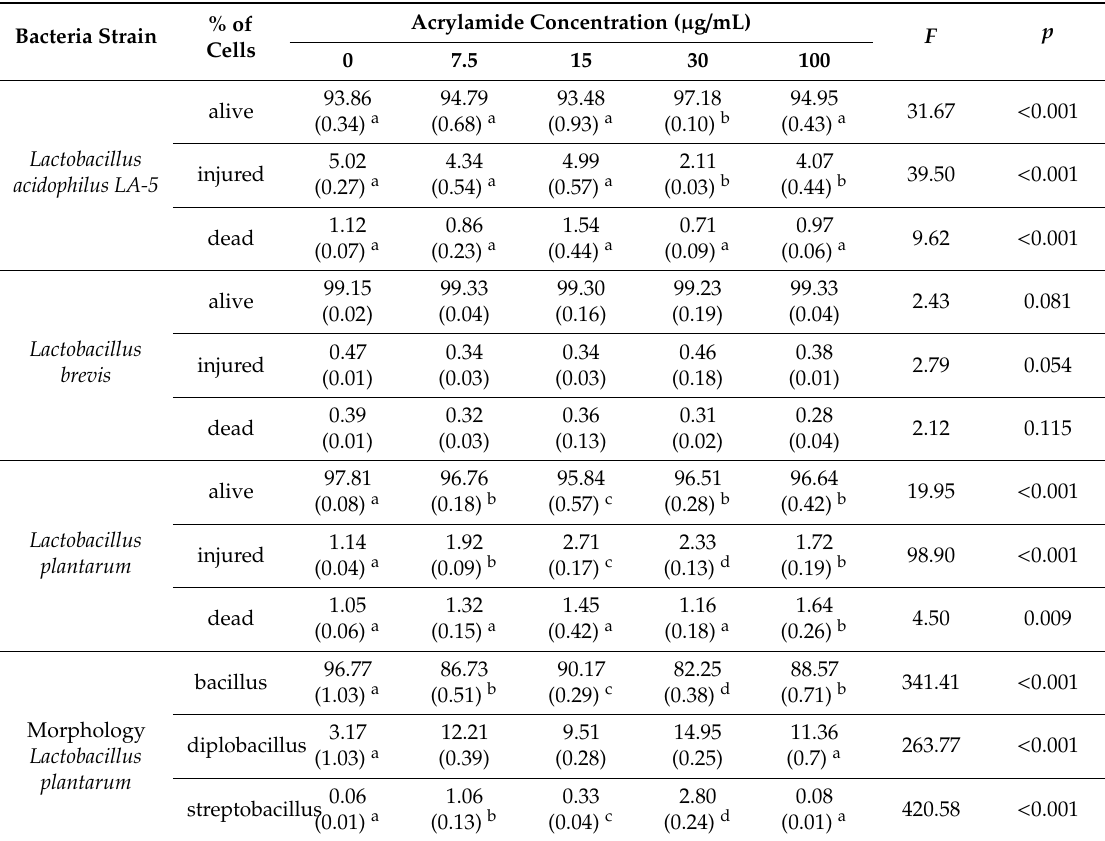
Table 3. The main e ff ect of acrylamide concentration: influence of acrylamide concentration on the percentage of occurrence of certain cell types (expressed as arithmetic mean (SD)), regardless of the incubation